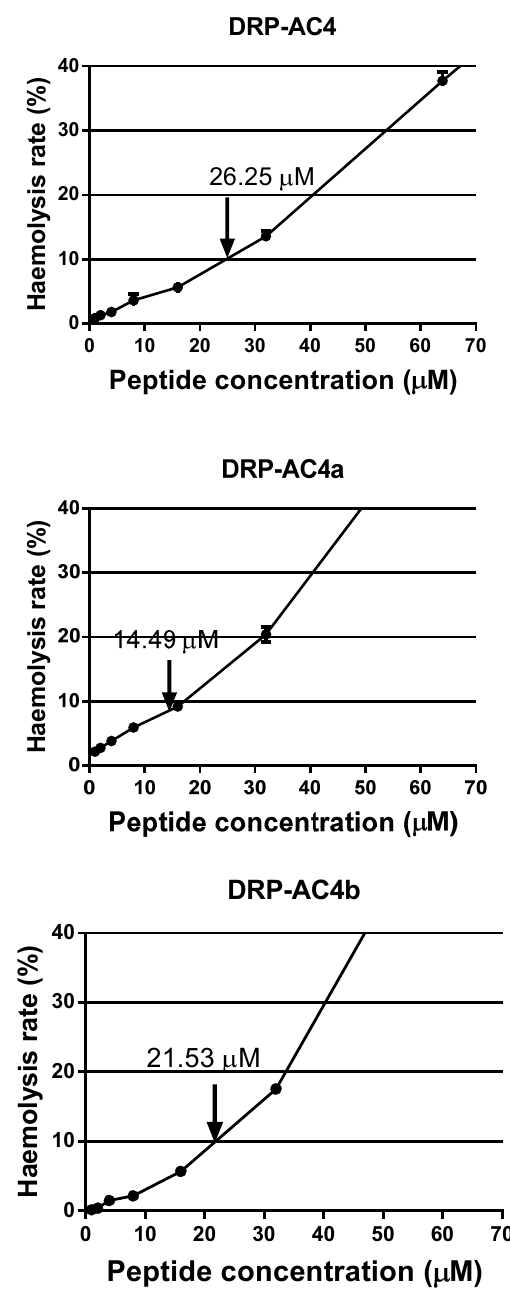
Figure 7. The haemolysis of horse red blood cells with different concentrations of DRP-AC4, DRP-AC4a and DRP-AC4b. The error bar represents the standard error of the mean (SEM) of fifteen replicates. Arrows indicate the haemolysis rate at the peptide concentration of the GM MICs.